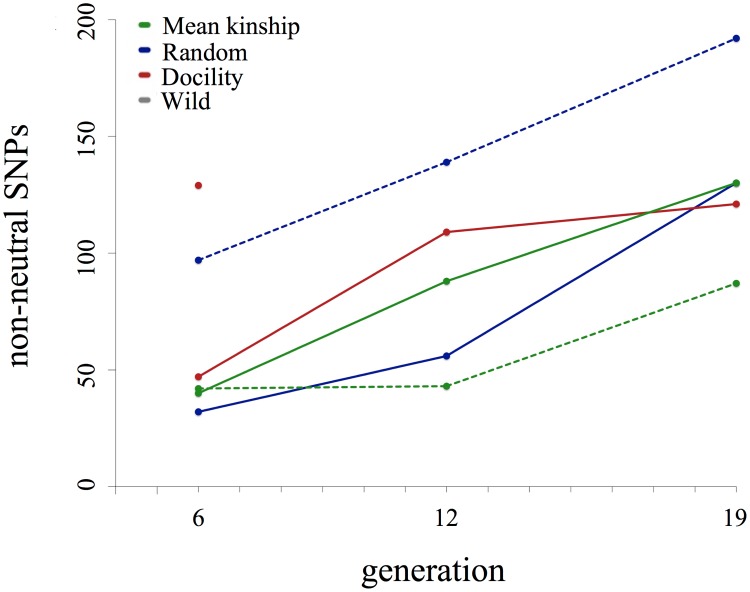
Comparison of the number of nonneutral SNPs detected per population at generations 6, 12, and 19.Replicate populations are shown by solid (replicate 1) and dashed (replicate 2) lines. Although no significant difference was detected between different breeding protocols (ANOVA: F = 4.8037, df = 2, p = 0.19), the number of nonneutral SNPs identified per generation was significantly higher in generation 19 compared to generation 6 (ANOVA: F = 1.911, df = 2; Tukey: g19-g6: diff = 67.5, adjusted p = 0.026).